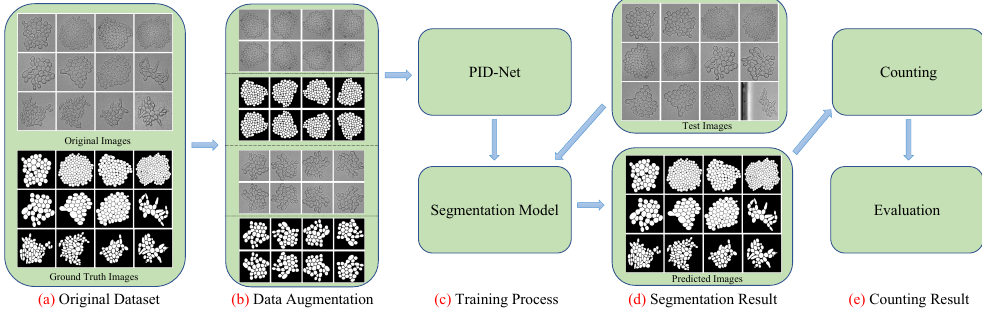
Figure 1. The workflow diagram of the proposed yeast image counting method using PID-Net. In Figure 1, (a) Original Dataset: The dataset contains images of yeast cells and their ground truth (GT). The range is from 1 to 256 yeast cells in each image. (b) Data Augmentation: Mirror and rotation operations are applied to augment the original dataset. (c) Training Process: PID-Net is trained for image segmentation and the best model is generated. (d) Segmentation Result: Test images are processed using the trained PID-Net model and output the predicted segmentation results. (e) Counting Result: The number of yeast cells is counted by using connected domain